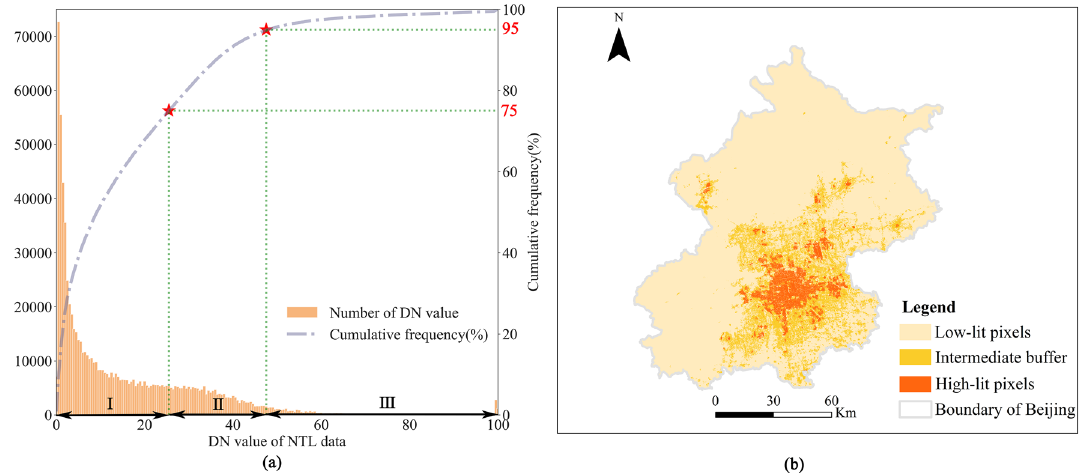
Figure 3. The histogram statistics and spatial result of Beijing’s NTL data, which was obtained from VIIRS Nighttime Lights dataset in 2018. ( a ) The histogram statistics of DN values and its cumulative frequency; ( b ) spatial result of DN values divided into three parts after the